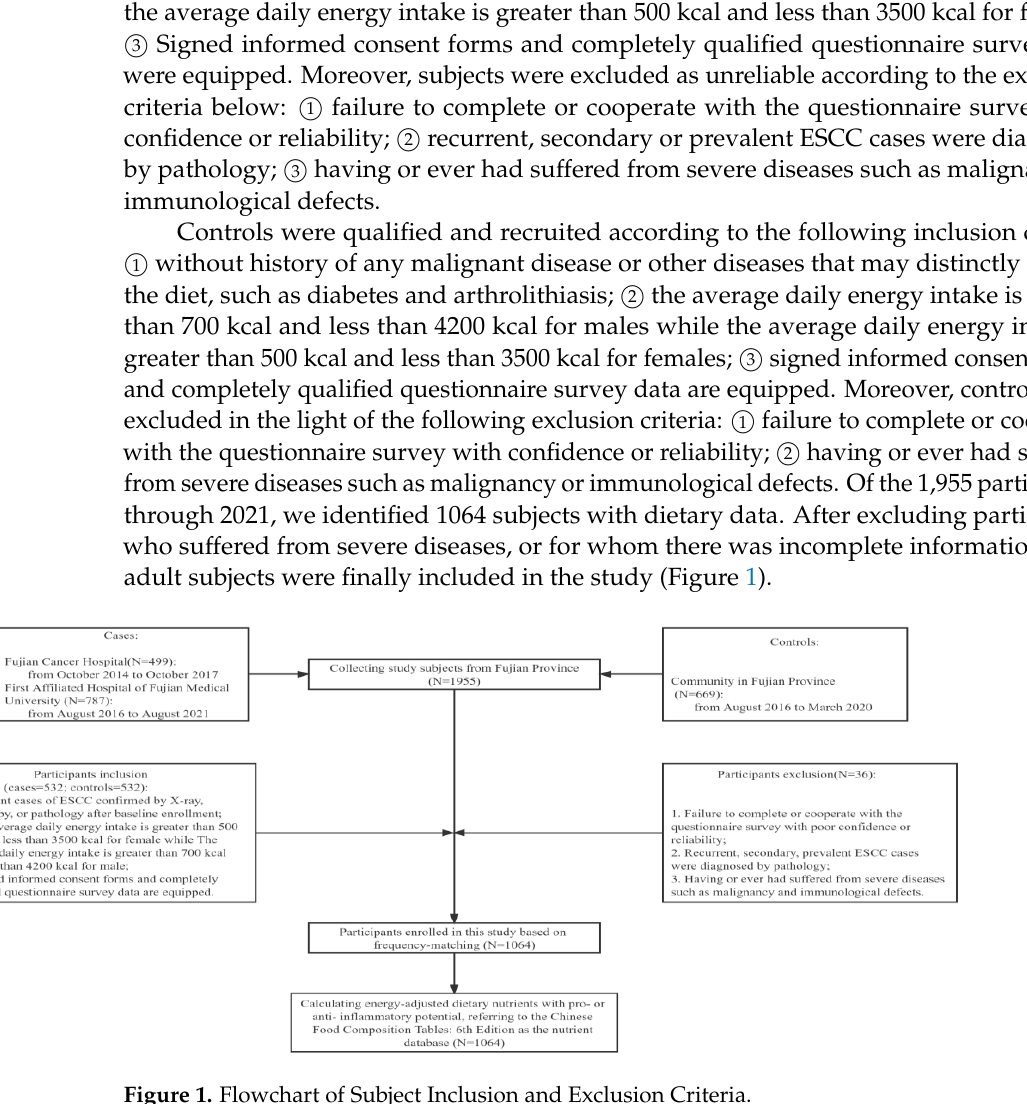
Figure 1. Flowchart of Subject Inclusion and Exclusion